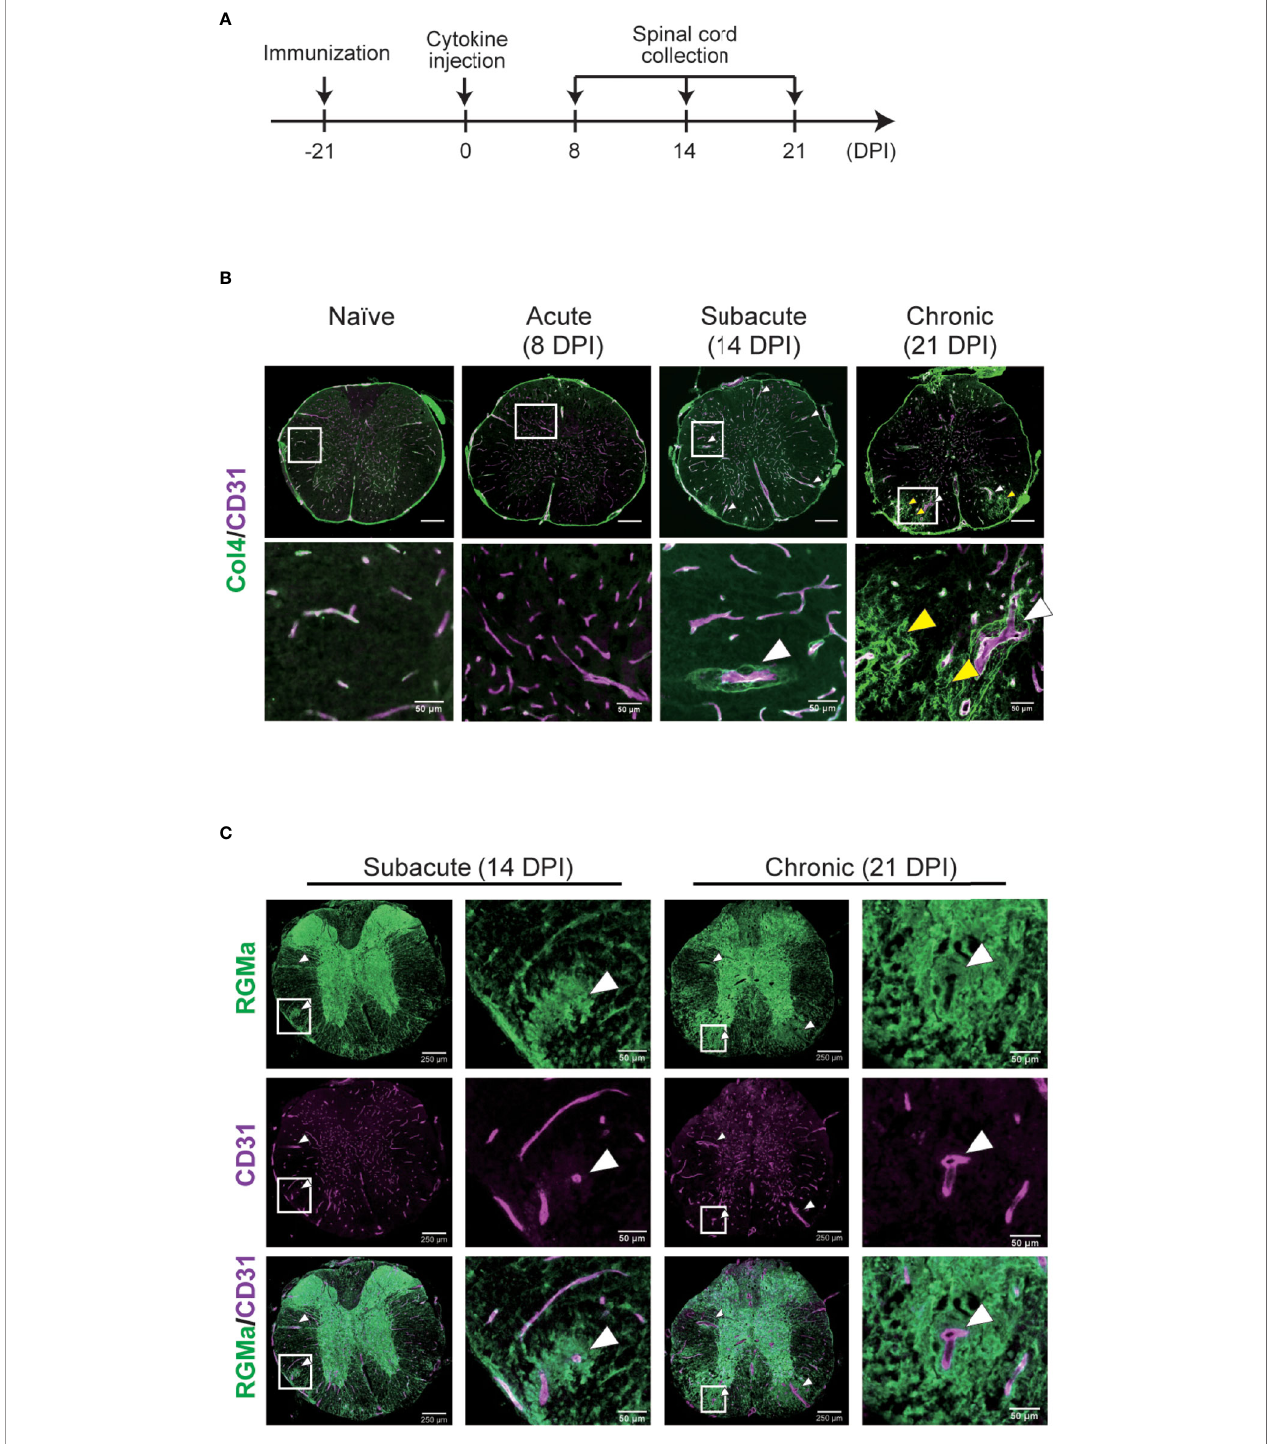
FIGURE 6 | Immunohistochemical analysis of the spinal cord in targeted EAE mice. (A) Experimental time course of IHC analysis. (B) Representative image of the whole spinal cord stained with anti-CD31 and anti-type IV collagen antibodies at each disease phase in naïve mice and targeted EAE mice at 8, 14, 21 DPI. (C) Representative image of anti-RGMa and anti-CD31 antibodies staining in targeted EAE mouse spinal cords at 14 and 21 DPI. White and yellow arrows indicate abnormal vessels and collagen mesh formation, respectively. Scale bar; 50 m m (magni fi ed), 250 m m (whole spinal